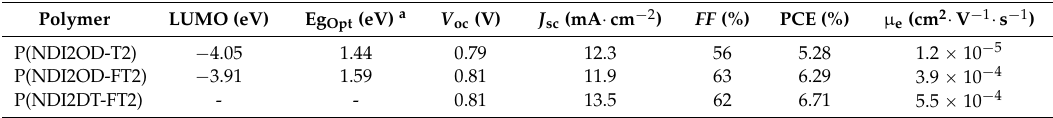
Table 6. The n -type polymer properties and photovoltaic device parameters.